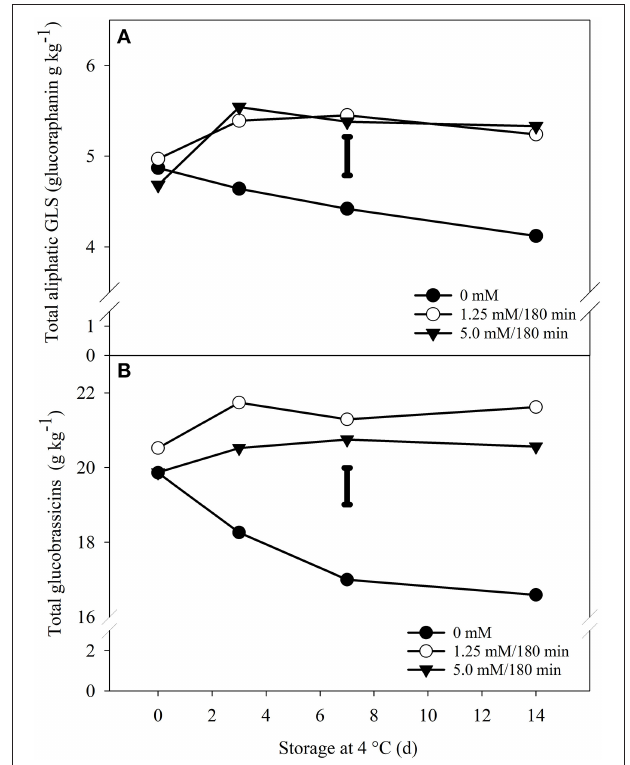
FIGURE 4 | Effect of H 2 O 2 exposure on total aliphatic and indole-type glucosinolates of broccoli florets. Total aliphatic (glucoraphanin) (A) and indole-type (B) glucosinolates in broccoli florets exposed to three doses of H 2 O 2 , 0mM (•), 1.25 mM/180min ( ) and 5 mM/180min ( H ) during storage in ◦ the dark for 14 d at 4 ◦ C. Values are g equivalents of sinigrin on a dry weight basis and represent the mean of 3 replicates per treatment ( n 3). The bars in = each graph represents the LSD value (0.05) 0.42 (A) and 0.98 (B) . Sampling = on day 0 was performed 6h after the end of the treatments.